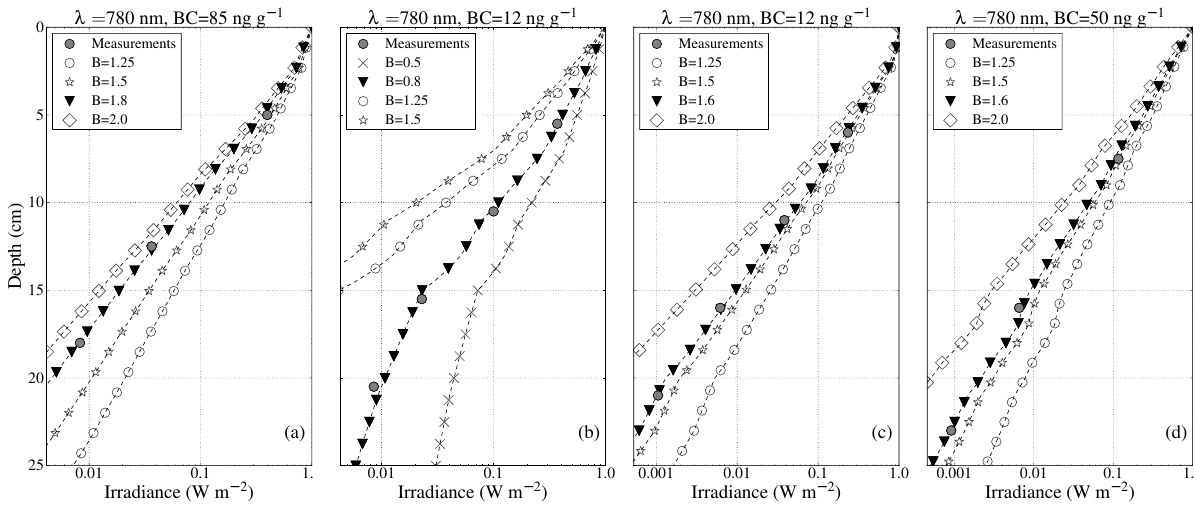
= 780nm (the corresponding vertical profiles of k e